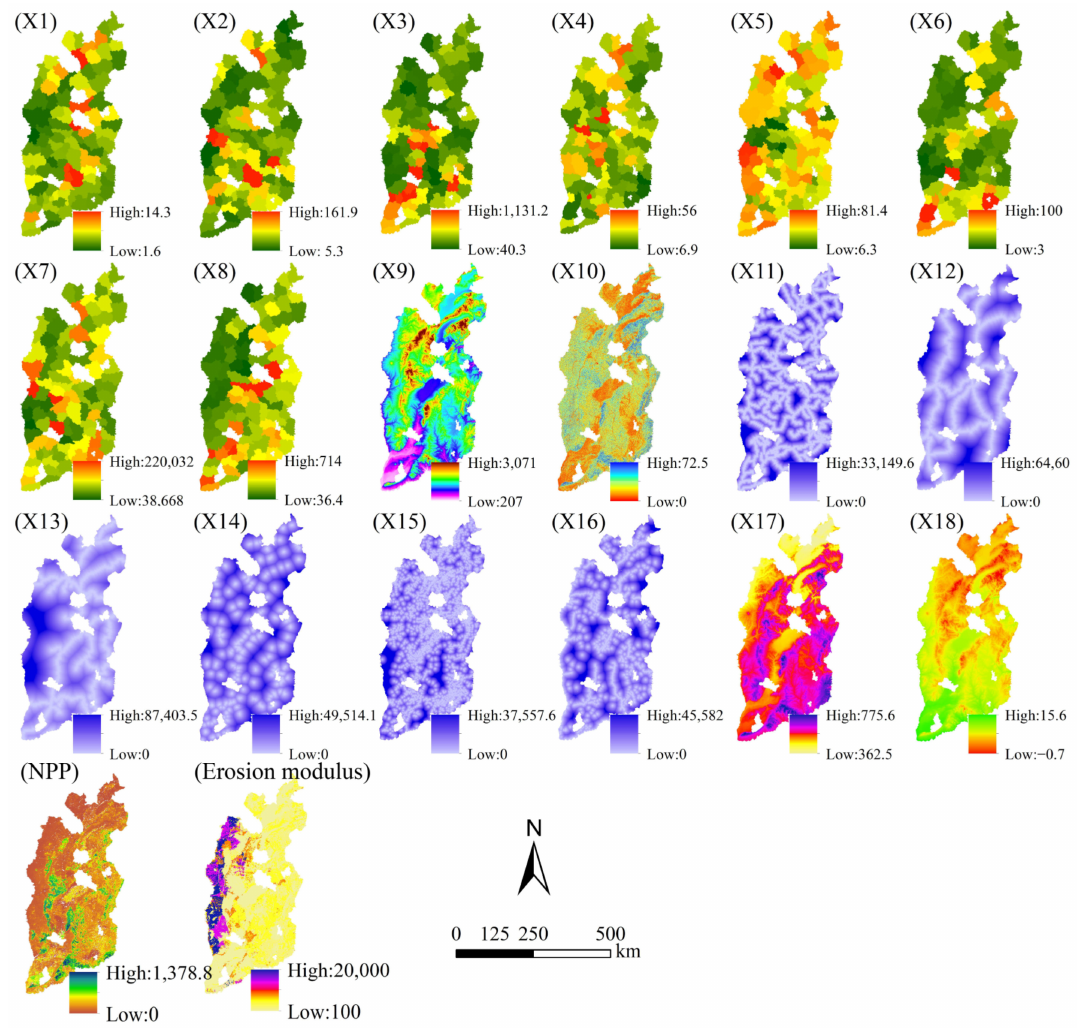
Figure 2. Driving factors of